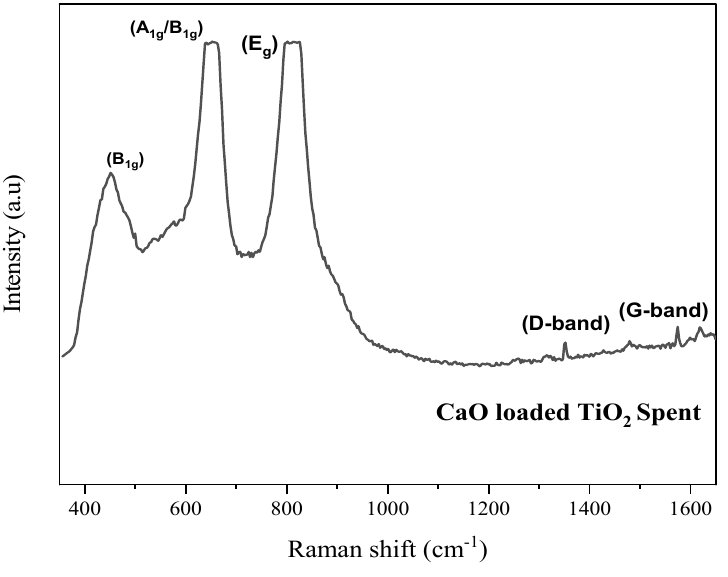
Figure 8. Raman spectra of CaO loaded TiO 2 spent.